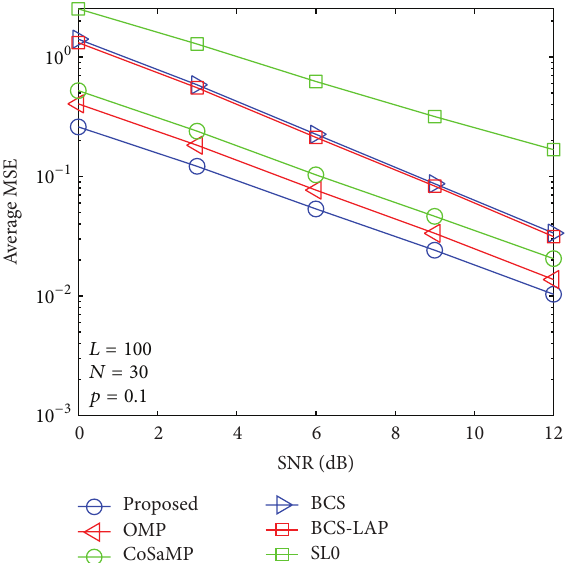
Figure 6: Average MSE performance versus SNR when 𝑝 1 = 0.1 and 𝑁 = 30 .